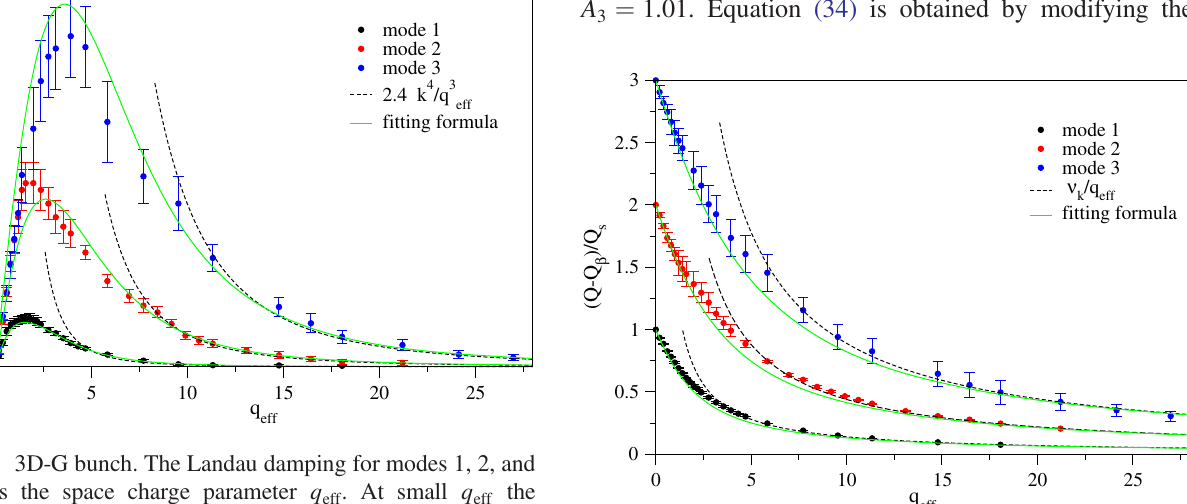
. At small q the eff eff . In the strong eff 4 2 π Q s FIG. 7. 3D-G bunch. The relative tune shift, , q 3 eff modes 1, 2, and 3 versus the space charge parameter q strong space charge regime, q > ≈ 4 k , Δ Q k ment with the theoretical prediction. ν 1 ¼ 1 . 4 , ν 2 ¼ 4 . 4 , and ν ¼ 8 . 9 [6]. The tune shift can be fitted reasonably well for the 3 entire range of the space charge strength by employing Eq. (34) (green lines).